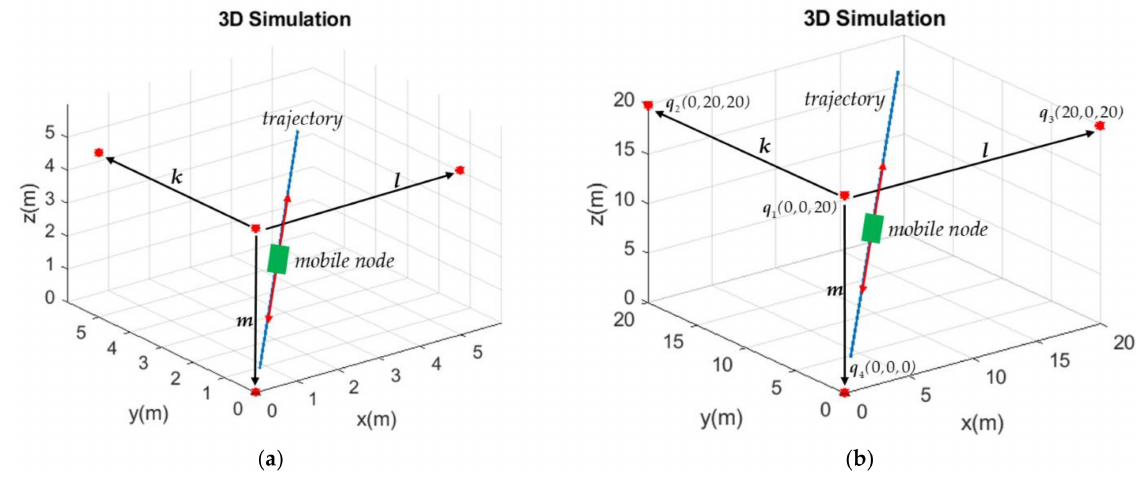
q , q and q and moving trajectory of the mobile node. ( a ) The environment 1 2 3 4